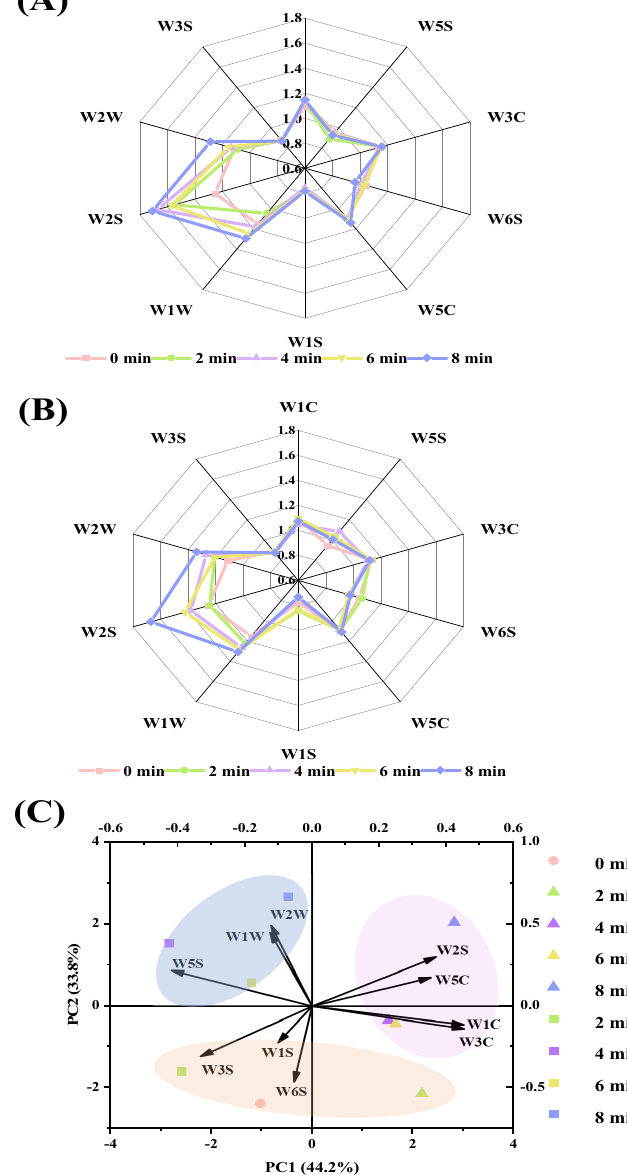
Figure 2. Radar chart of E-nose in tamarix lamb roasted by charcoal ( A ) or electric ( B ) and their principal component biplots ( C ) (W1C: aromatic compounds, W5S: nitrogen oxides, W3C: ammonia and aromatic compounds, W6S: hydrogen, W5C: alkanes and aromatics, W1S: methane, broad range of compounds, W1W: sulfur compounds, terpenes, W2S: alcohols, aldehydes and ketones, W2W: aromatics and organic sulfur compounds and W3S: long-chain alkanes. Triangle or square represented tamarix lamb roasted by charcoal or electric, respectively).